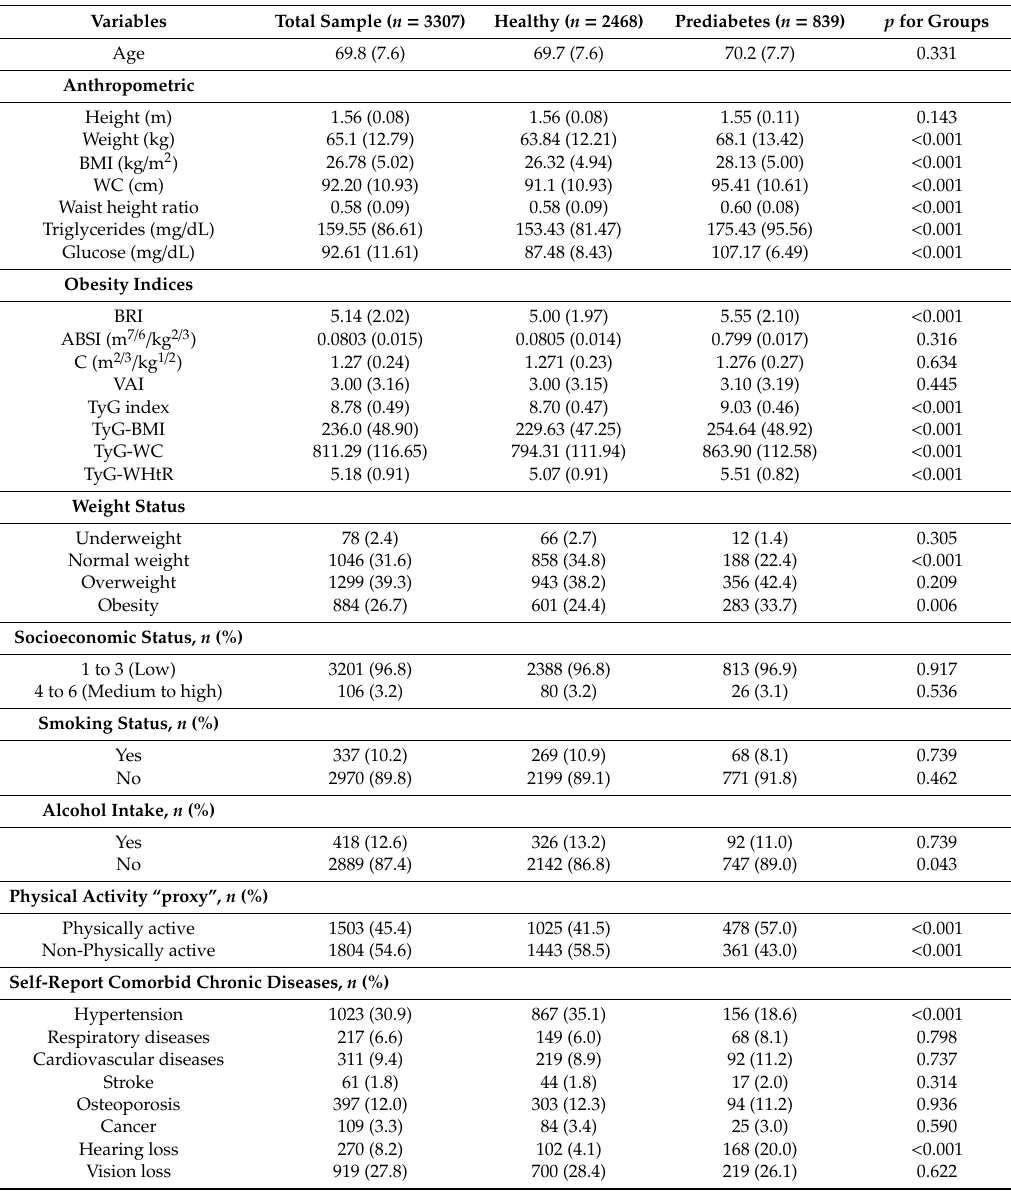
Table 1. Clinical and sociodemographic characteristics of study participants according to glycemic status among Colombian older